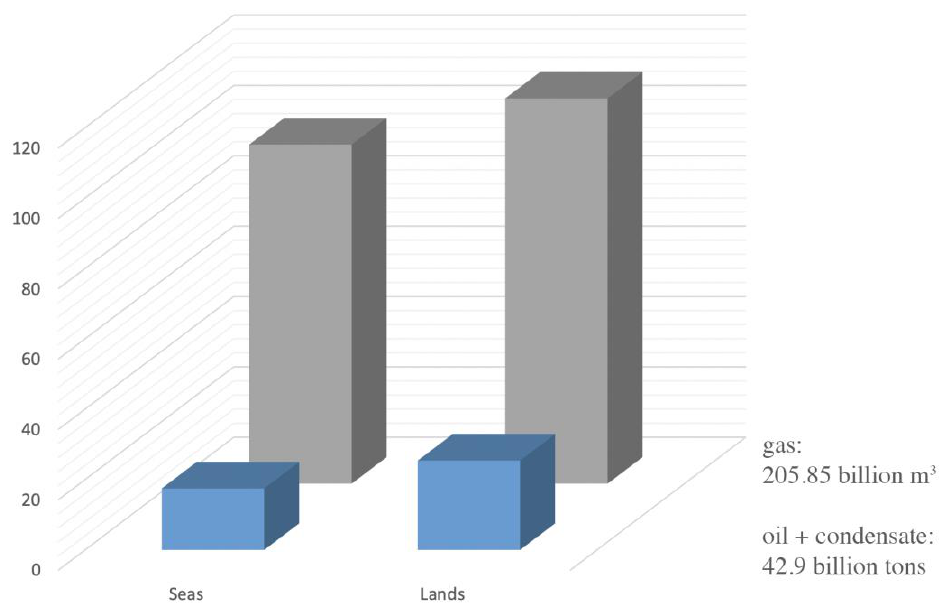
Figure 17. Distribution of oil and gas (free plus dissolved) resources in the Arctic zone of Russia according to the quantitative assessment as of 01/01/2019, after [40].